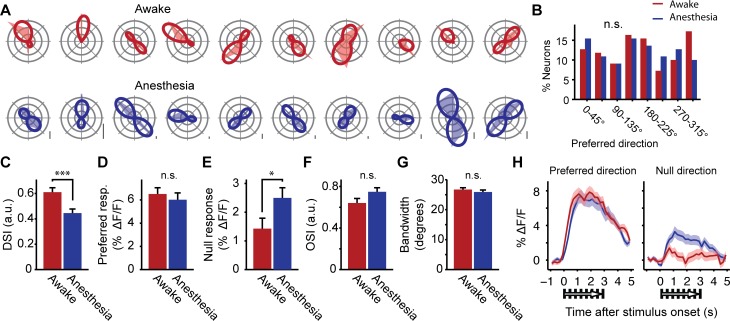
Orientation tuning of visual cortex neurons.(A) Top row: Polar plots show raw tuning curves and curve fits (dotted lines) of significantly orientation-tuned neurons in the awake condition. Bottom row: Idem, but for the same neurons under anesthesia. Scale bar measures 2% ΔF/F. (B) Distributions of preferred directions. No significant differences were found between awake and anesthesia. (C) Mean (± SEM) direction selectivity index (DSI). (D) ΔF/F response to the preferred direction. (E) ΔF/F response to the null direction. (F) Mean orientation selectivity index (OSI). (G) Mean tuning curve bandwidth. (H) Average (± SEM) ΔF/F response to visual stimulation by preferred (left panel) and null direction (right panel) across cells as a function of time around stimulus onset. All panels: Red bars and lines indicate data from the awake condition, blue bars and lines represent data from the anesthetized condition (* p = 0.014, *** p = 0.00017).